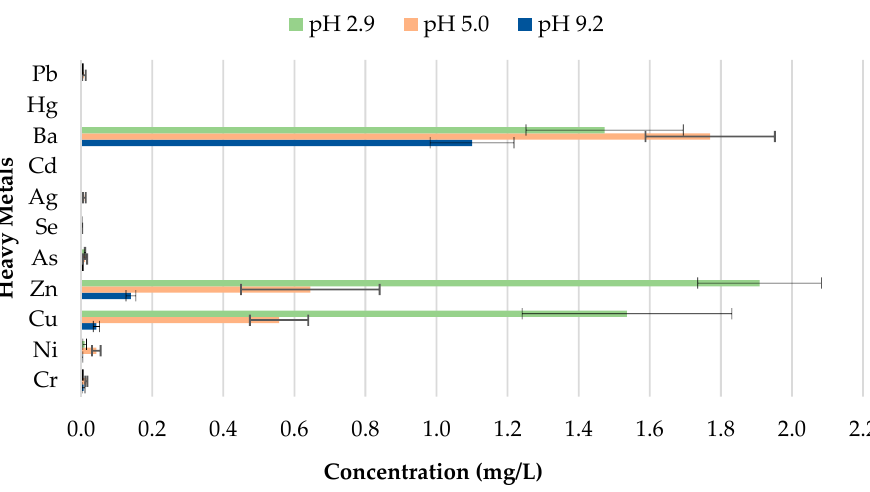
Figure 11. Leachate concentrations for crushed bricks with 0% CB content.